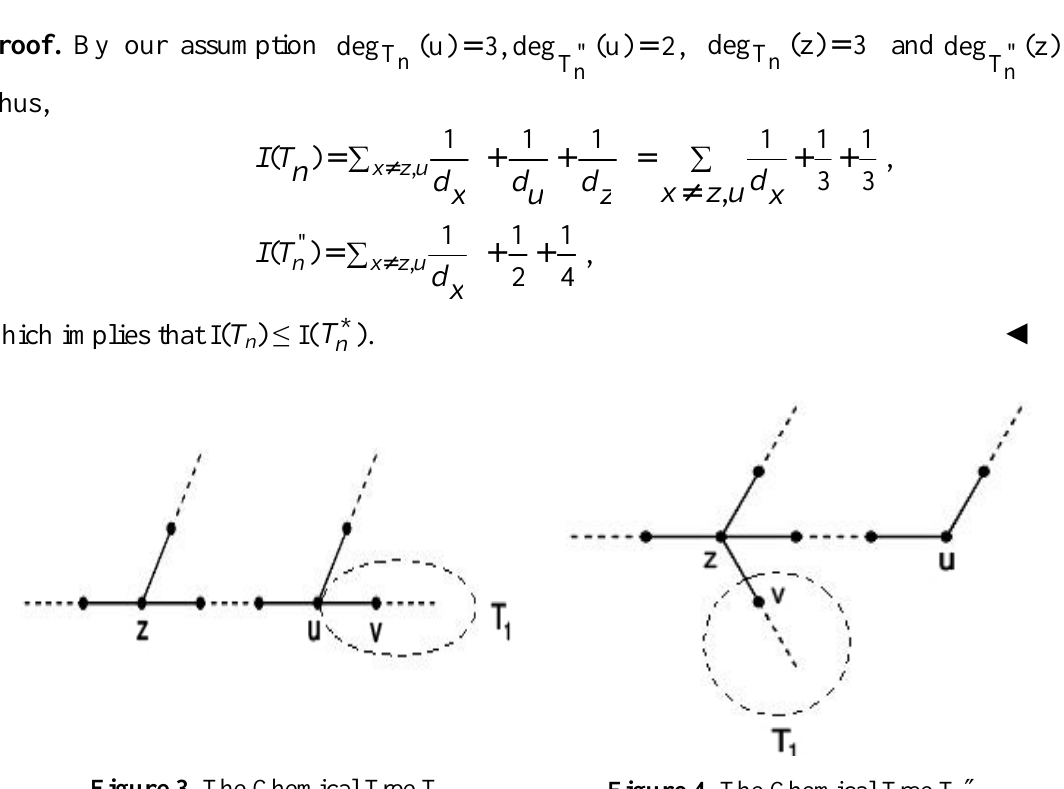
. Figure 4. The Chemical Tree T n